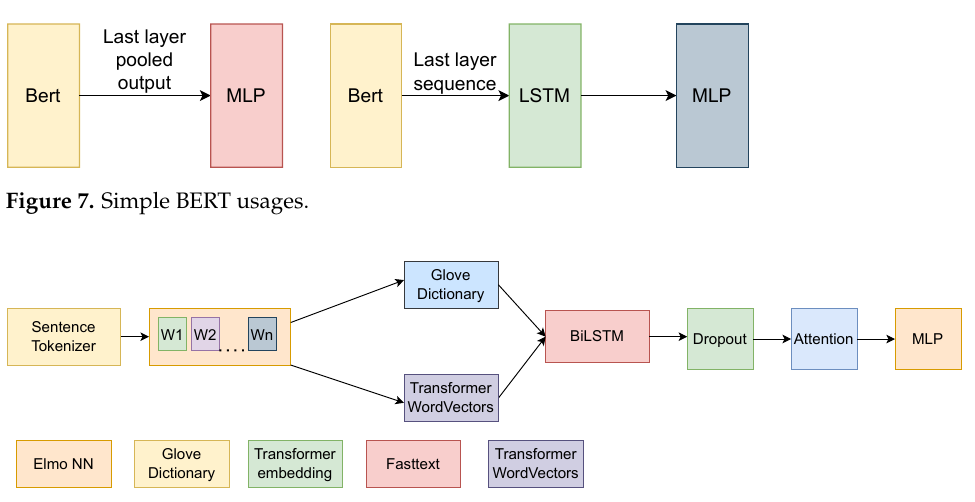
Figure 8. Single-task architecture.